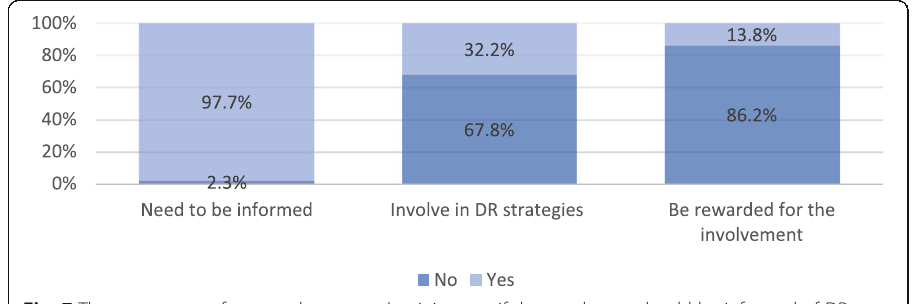
Fig. 7 The percentage of surveyed managers ’ opinions on if the employees should be informed of DR activities, involved in the activities or rewarded of the involvement in the activities. N =